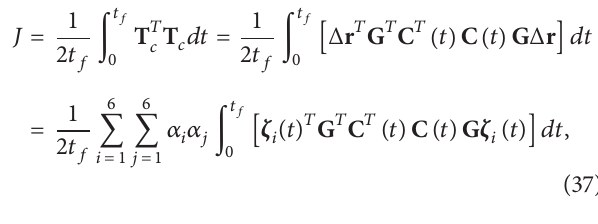
As confirmed by zero real part of the eigenvalues in